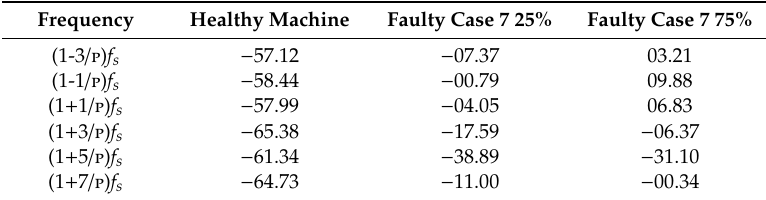
Table 7. Current harmonic components comparison due to case 7 (in dB).